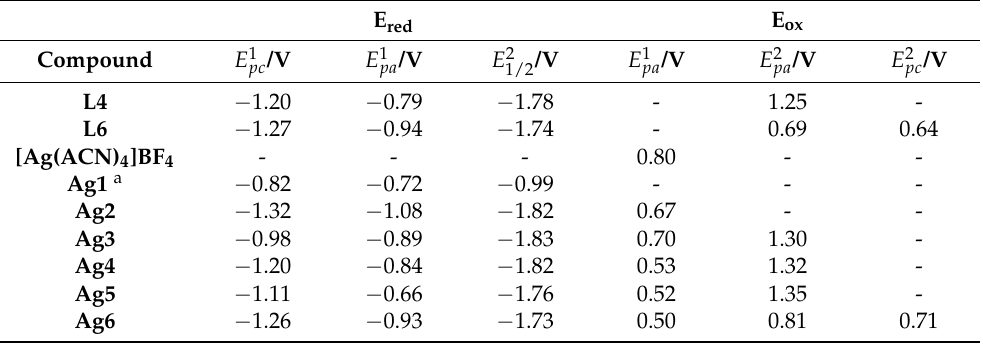
Table 2. Electrochemical characteristics of catalysts Ag1 – Ag6 compared with L4 , L6 and the